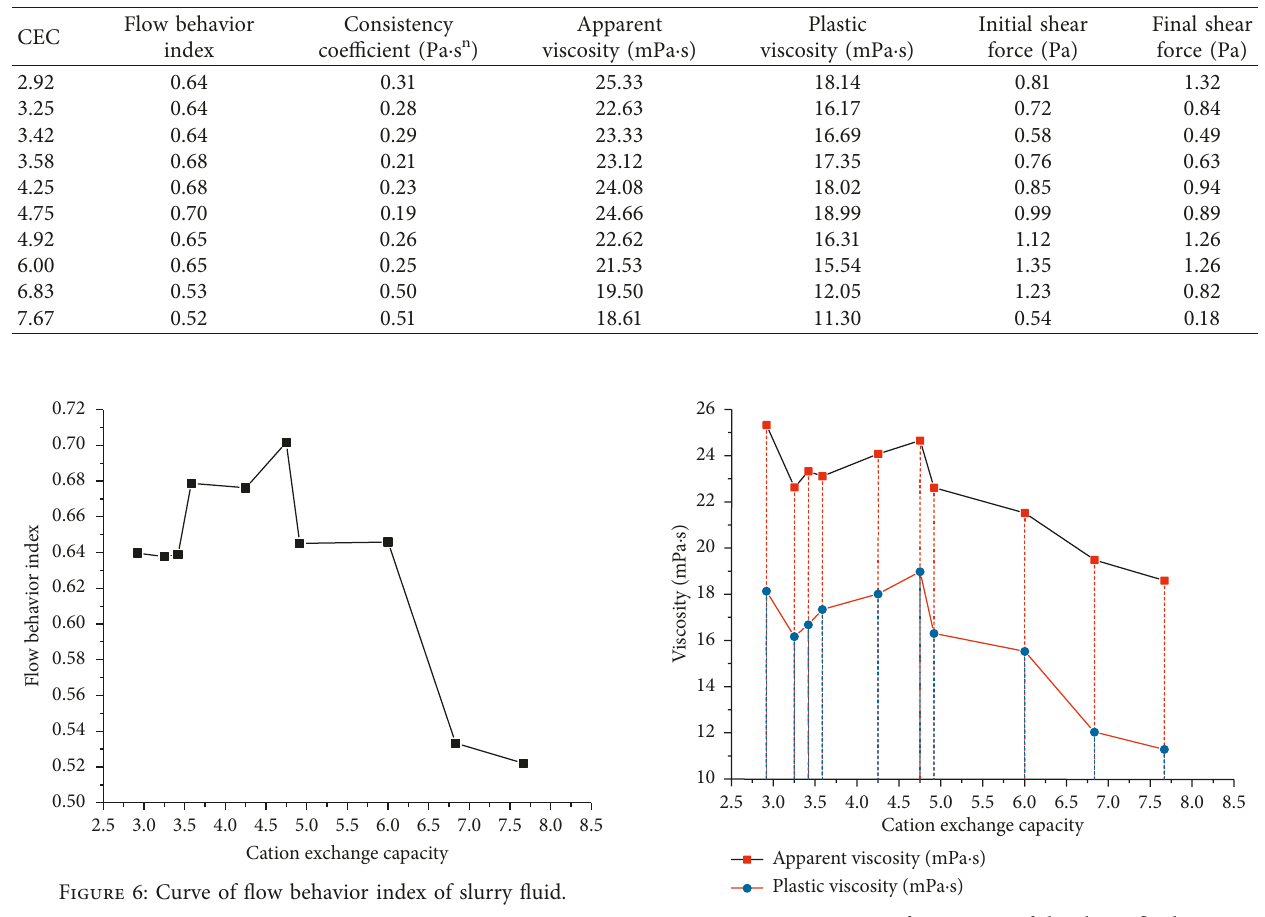
Table 3: Rheological parameters of slurry fluid with different cation exchange capacities.